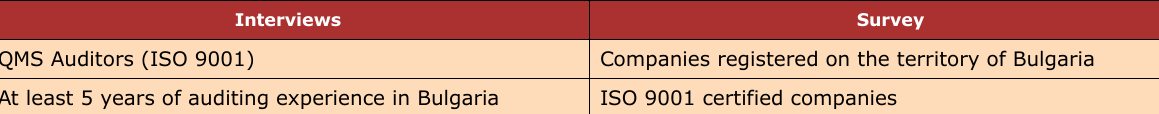
Table 2. Sampling